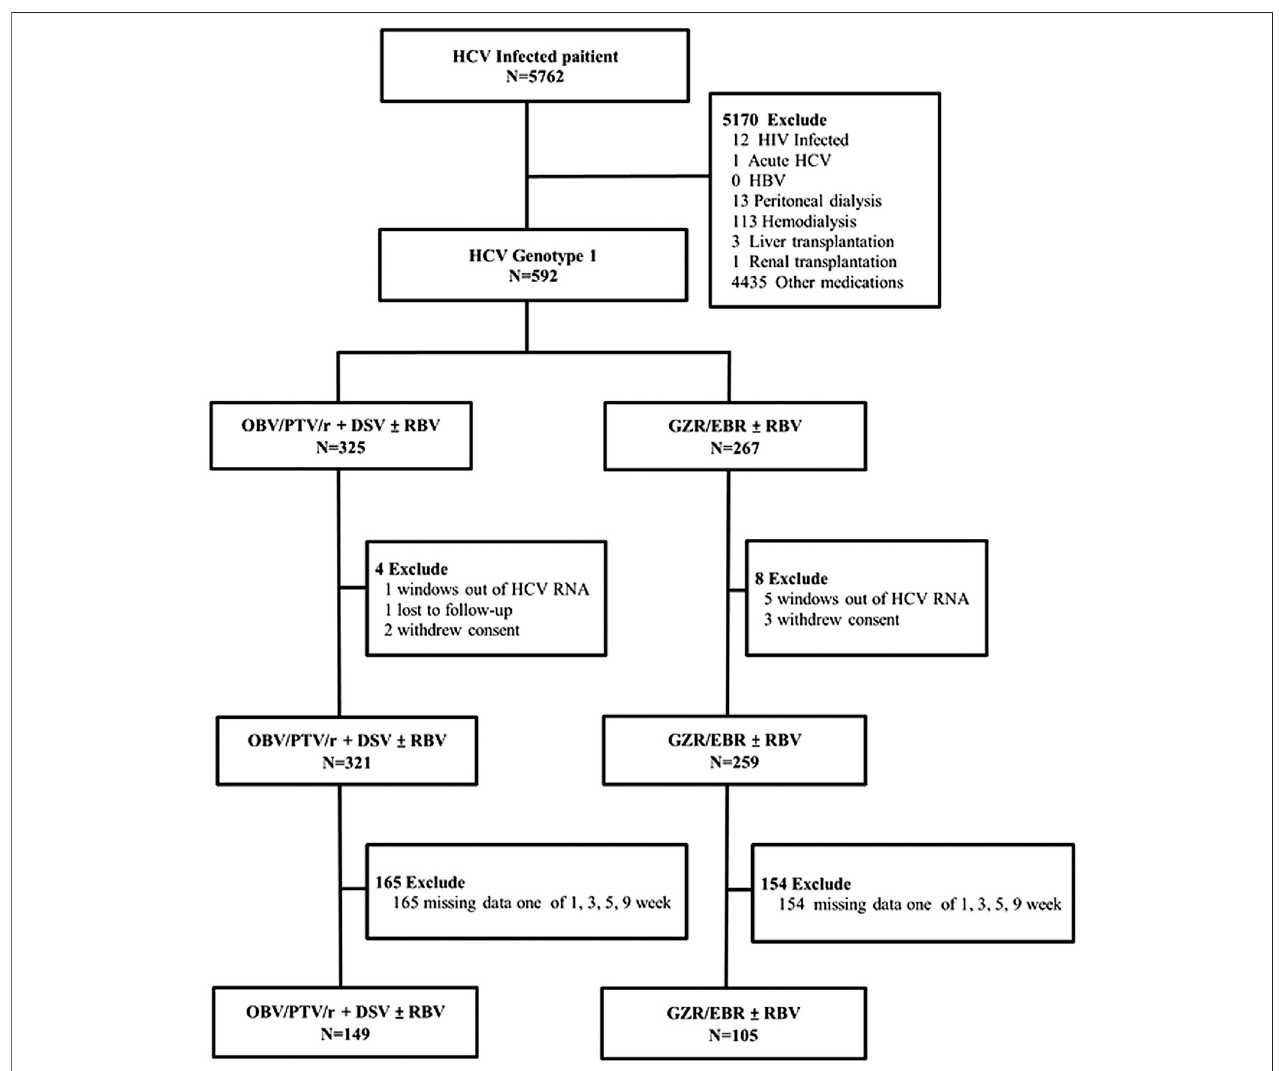
FIGURE 1 | Trial pro fi